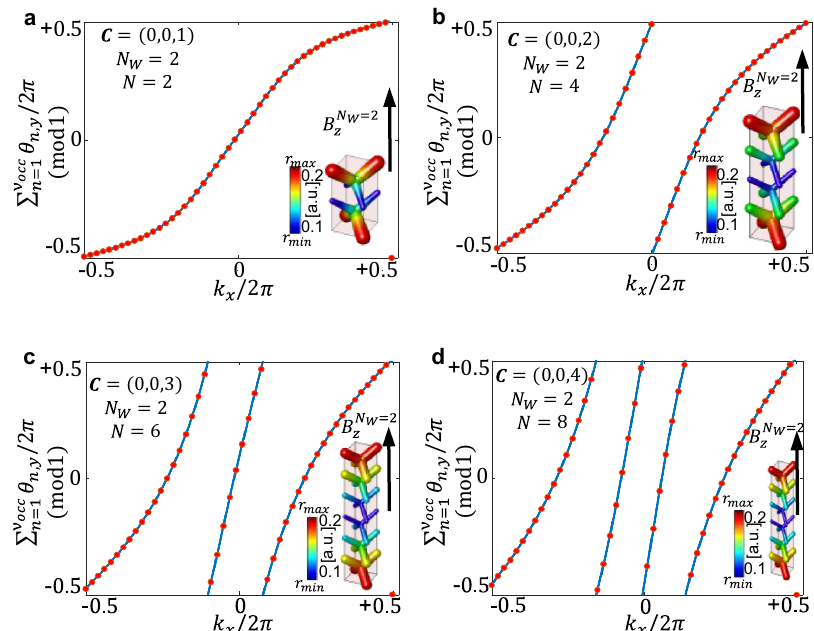
Fig. 3 Generating larger Chern numbers. Annihilation of Weyl points at N W = 2 over multi-fold supercells of even N . a Unit Chern number 3D CI. b , c , d Increasing Chern numbers C according to the relation C = N /2. Calculations performed on 1D supercells (1, 1, N ) with modulation parameter r m = r 0 /20 and WL on selected planes for k z /2 π = 0.3. Source data are provided as a Source Data fi